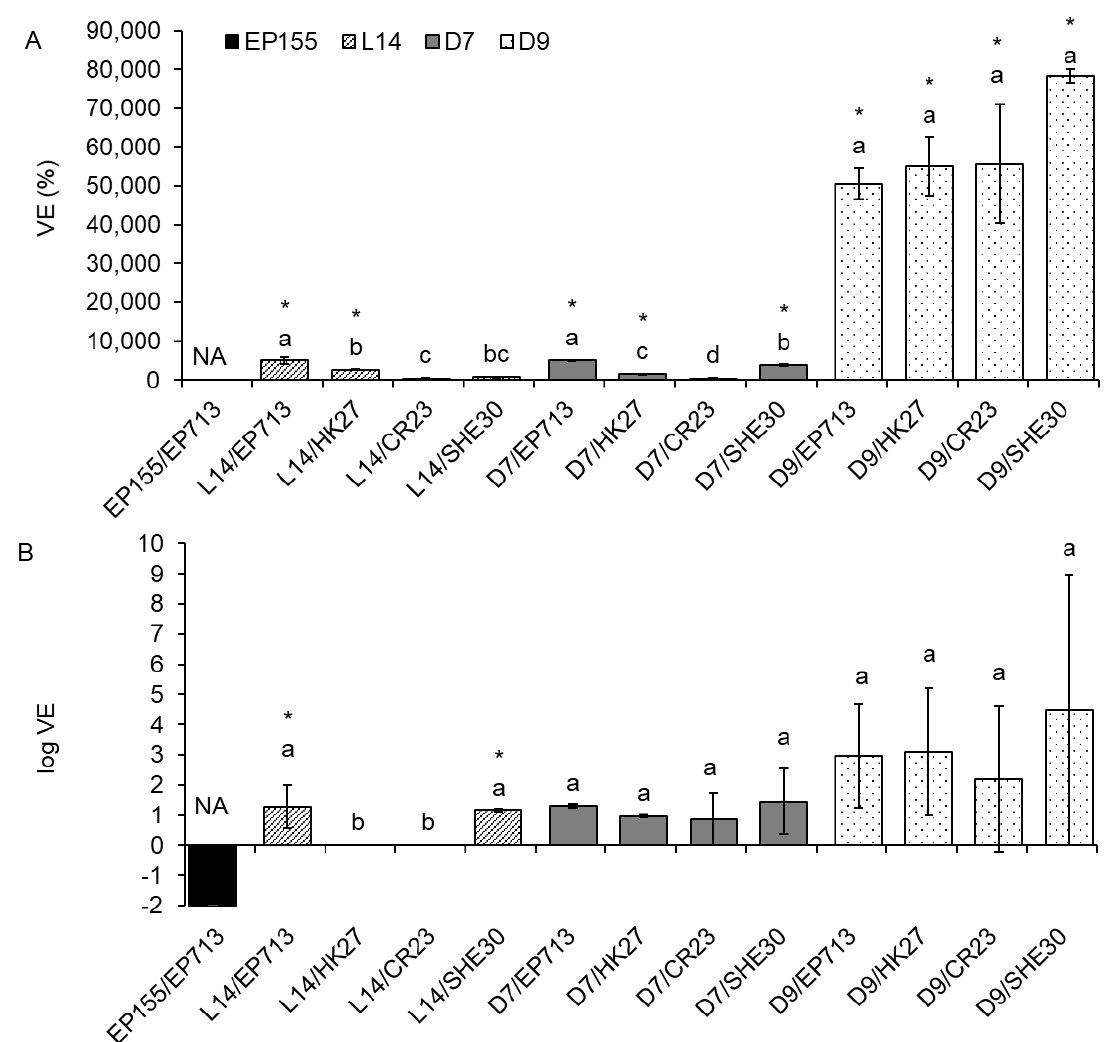
Figure 1. Effect of virus infection on solid media laccase (smLAC) activity of four Cryphonectria parasitica isolates when grown on ( A ) potato dextrose agar and ( B ) malt extract agar. Results in ( A ) are represented as mean virus effect (VE) value (difference between each triplicate measurement of HV isolate LAC activity and the mean of the corresponding isogenic VIR isolate LAC activity, given as a percentage of the performances of the VIR isolate) ± standard error. Results in ( B ) are in logarithmic scale. An asterisk (*) denotes virus-infected cultures with smLAC values significantly different from the corresponding VIR fungal isolate. Letters denote statistical differences between different virus strains infecting the same fungal isolate at p < 0.05. NA = not applicable to the statistical comparison of virus strains due to only one fungus/virus combination. The VE in EP155/EP713 ( A ) and L14/HK27 and L14/CR23 ( B ) amounted to zero, as in both VIR and HV fungi the smLAC activity was zero.